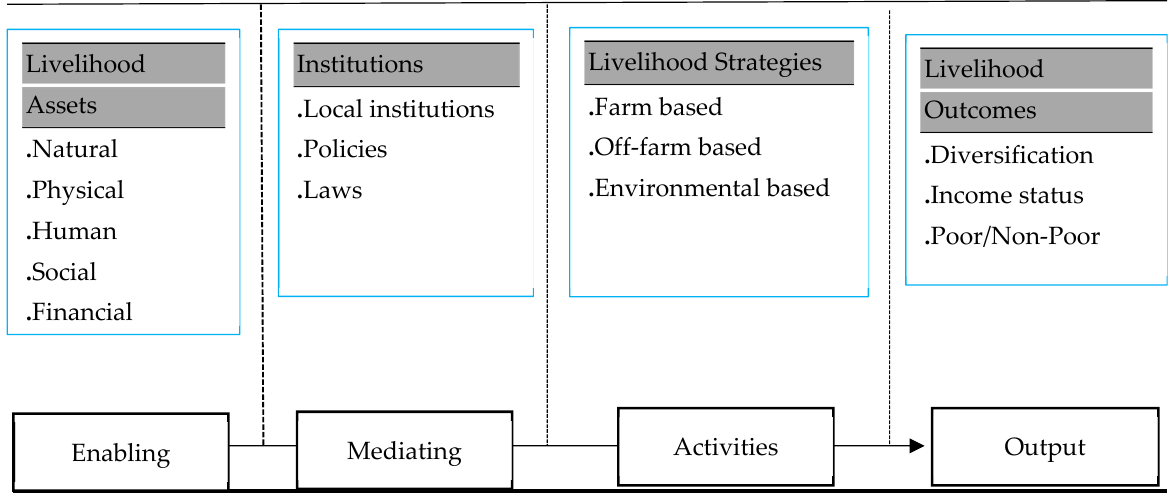
Figure 2. Adopted Sustainable Livelihood Framework used for conceptualizing the study [34,39].